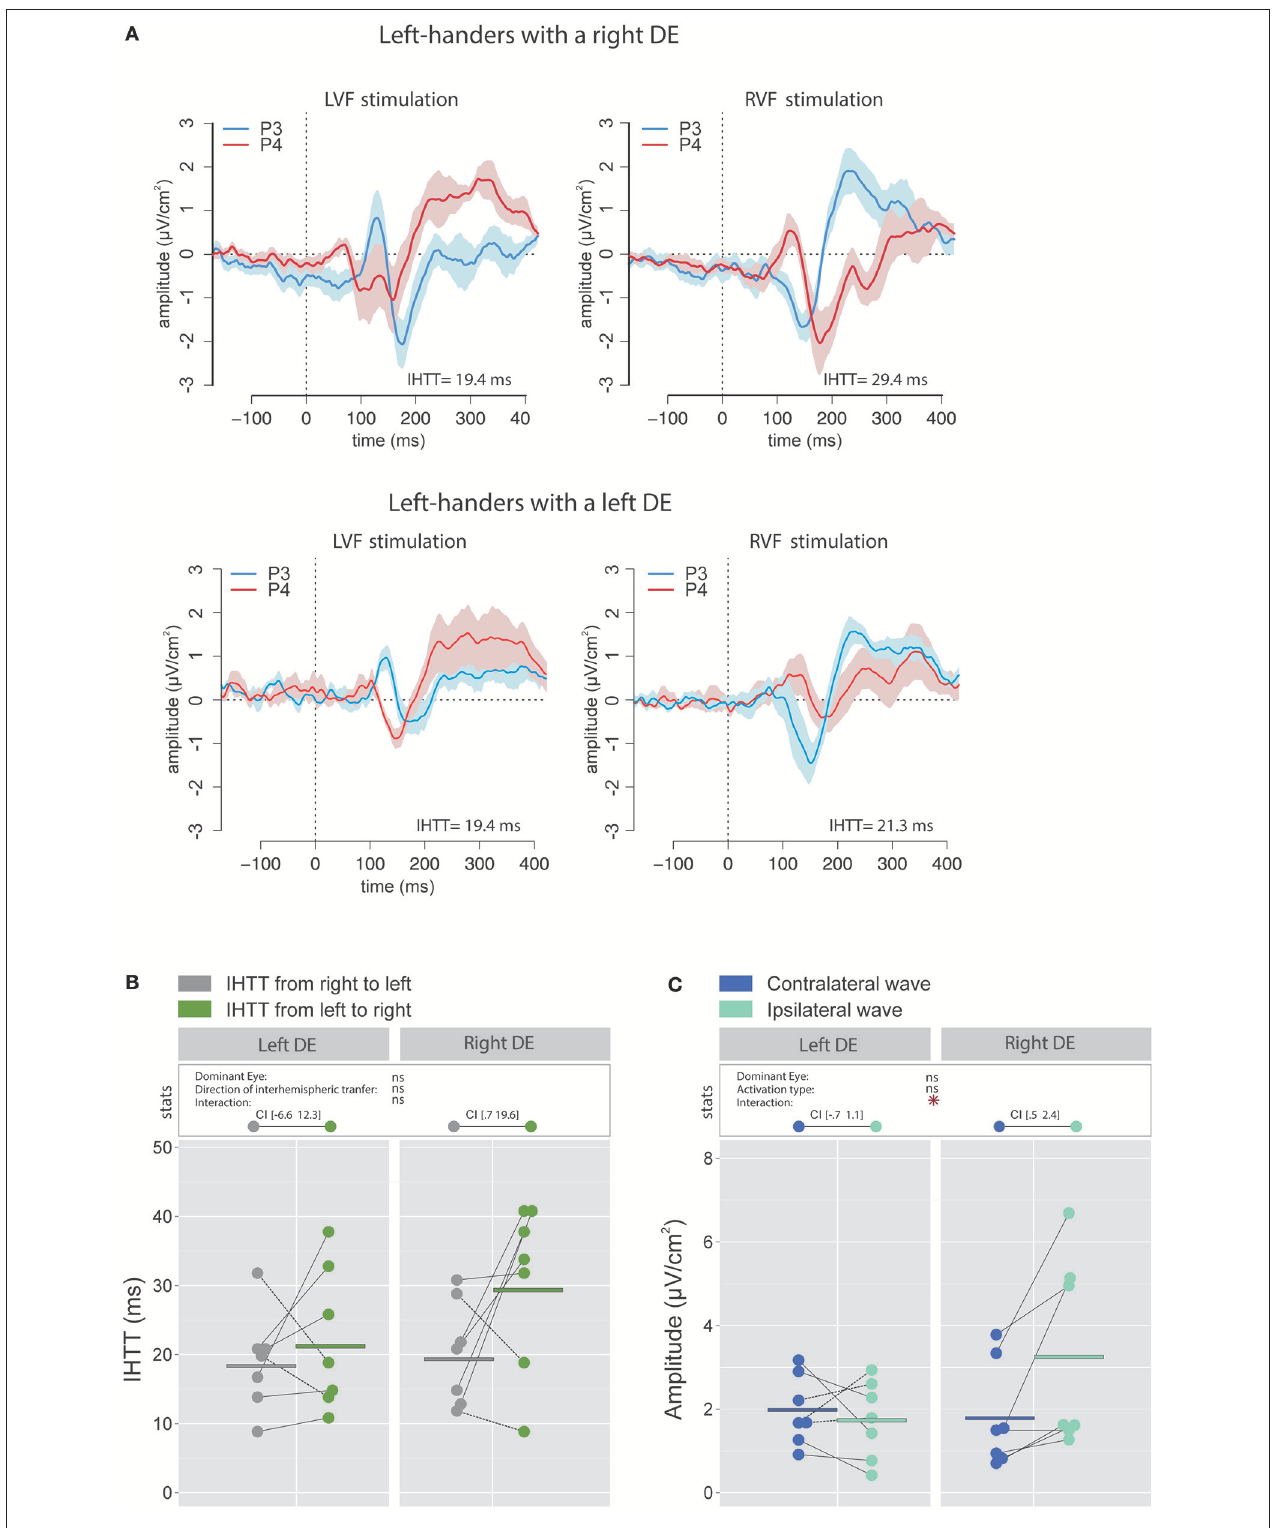
FIGURE 6 | Waveforms and average results computed over posterior sites after Laplacian transformation in left-handers. (A) Grand average CSD waveforms recorded over P3 (blue waves) and P4 (red waves) electrodes in the two experimental conditions (LVF or RVF stimulation). Shading blue and red areas represent